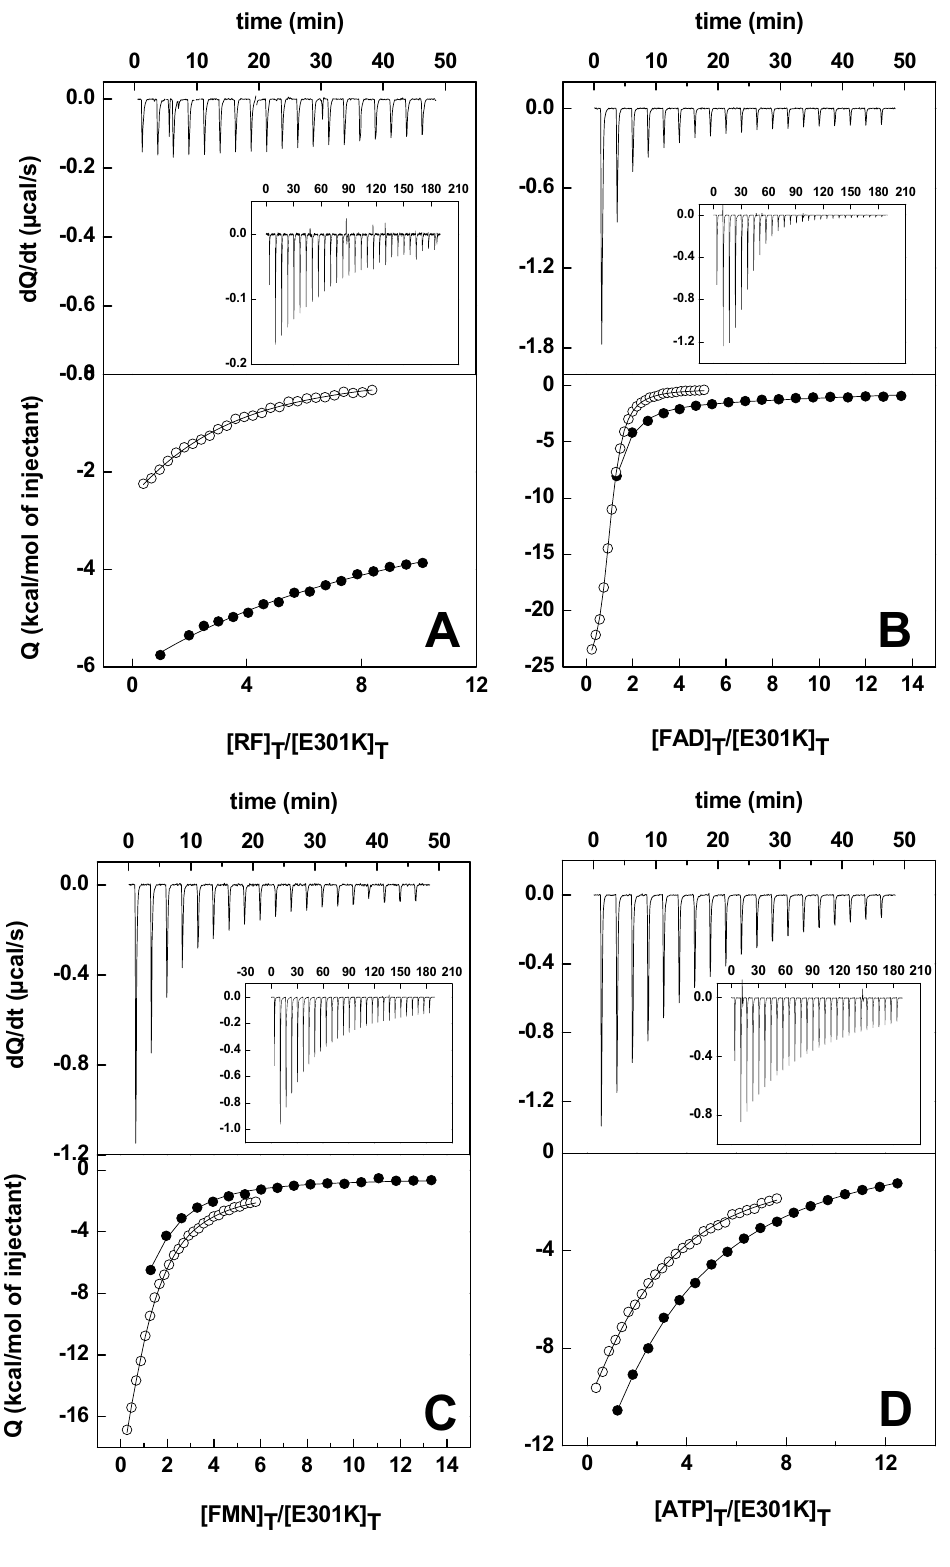
Figure 3. Calorimetric titrations of Ca FADS with: ( A ) RF, ( B ) FMN, ( C ) FAD and ( D ) ATP. Upper panels show thermograms for E301K and WT (inset) and lower panels show the corresponding binding isotherms with normalized integrated heats for E301K ( ● ) and WT ( ○ ). Experiments carried out in 20 mM PIPES, 10 mM MgCl 2 , pH 7.0, at 25